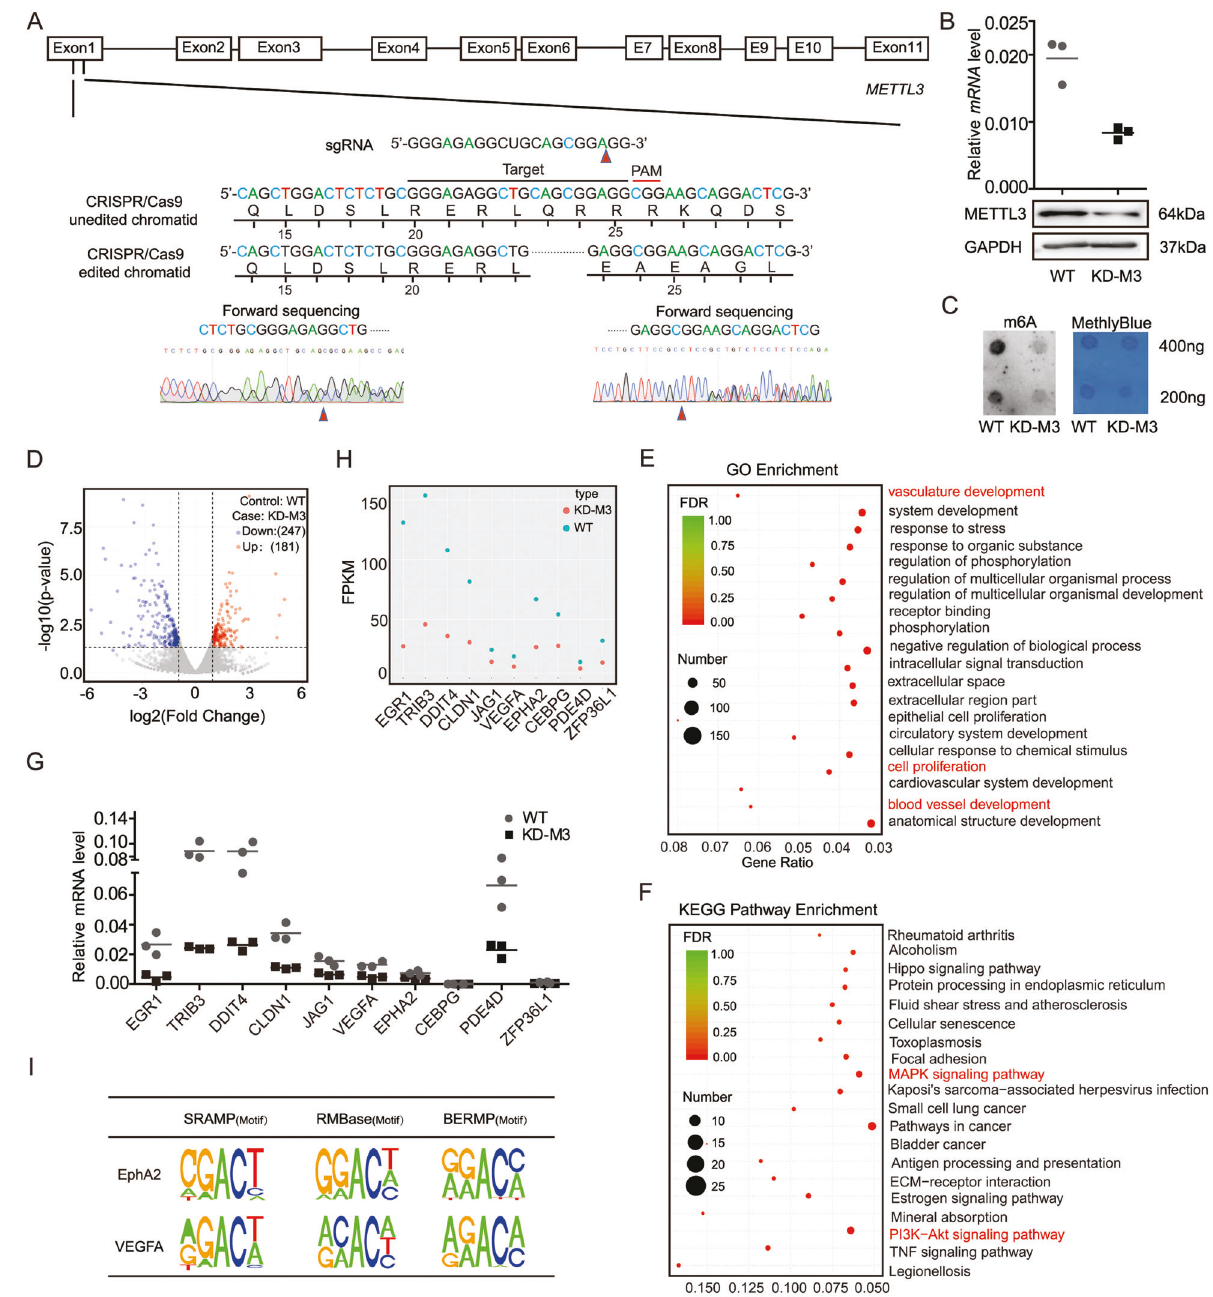
Fig. 2 Transcriptome-sequencing identi fi ed EphA2 and VEGFA as direct targets of METTL3 that in fl uence vasculature development. A Schematic of CRISPR/Cas9-mediated deletion of METTL3 and identi fi cation of METTL3 deletion clones by sequencing. B METTL3 expression levels were signi fi cantly decreased in METTL3-knockdown cells, as demonstrated by qRT-PCR, western blotting, and ( C ) m6A dot blot analysis. D RNA-Seq identi fi ed differentially expressed genes in METTL3 stable knockdown cells compared with their corresponding controls. E , F GO enrichment and KEGG analysis of differentially expressed genes. G , H Scatter diagram and qRT-PCR analysis of the expression of the top ten most signi fi cantly down-regulated genes. I Identi fi cation of the METTL3 consensus motif (GGAC) in the target EphA2 and VEGFA mRNAs using SRAMP/RMBase2.0/BERMP website tools. The data in ( B ) and ( H ) were normalized to GAPDH expression levels. p values were calculated using t test from three independent experiments. *** p < which could be rescued by overexpression of EphA2 or VEGFA. RNA-seq data analysis, EphA2 and VEGFA were enriched in growth Additionally, the proliferation of METTL3 knockdown cells co- and vasculature development in HCT116 cells (Fig. 2H); therefore, expressing EphA2 and VEGFA increased more than that in cells we evaluated the tumor ‑ promoting ability of METTL3 and its overexpressing EphA2 or VEGFA alone (Fig. 5A). target genes, EphA2 and VEGFA , by upregulating EphA2 and Furthermore, to con fi rm the effects of METTL3 on cell VEGFA using a GV230 overexpression vector. The results of an MTT proliferation, we performed a clonogenic assay. The results assay showed that METTL3 silencing reduced cell proliferation,